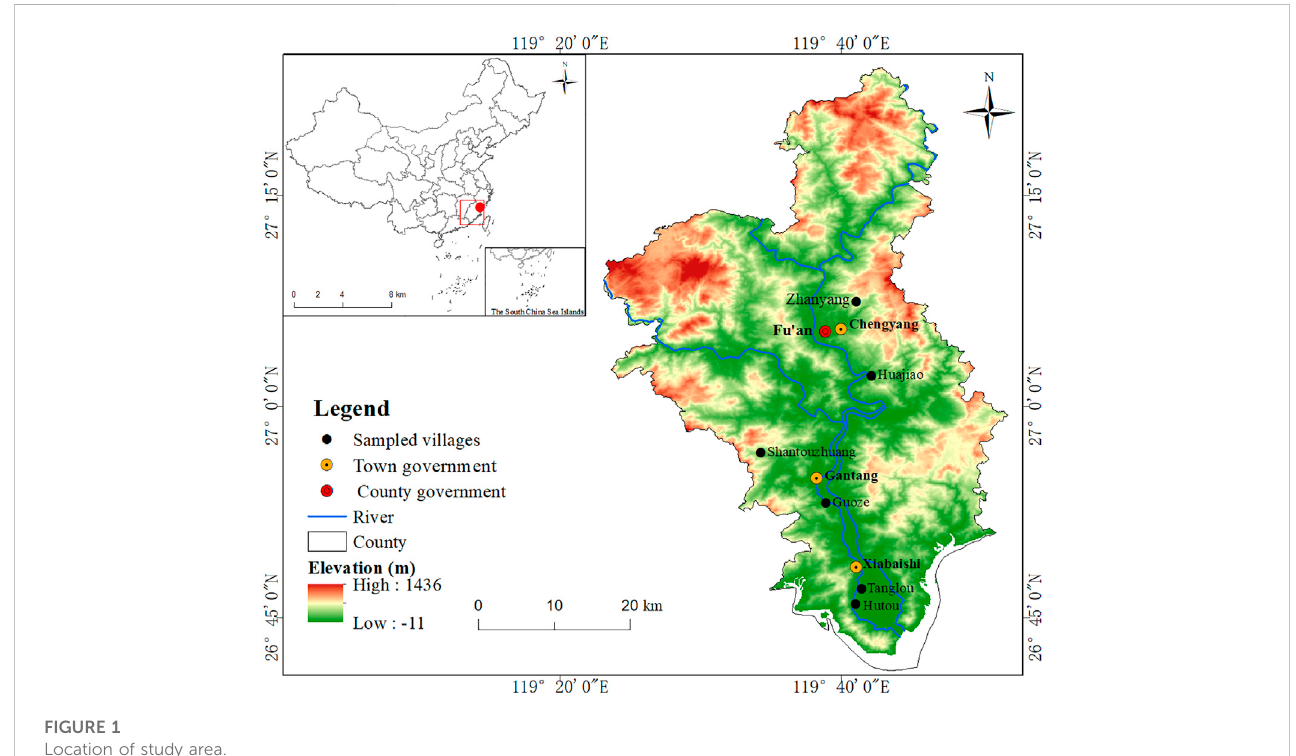
FIGURE 1 Location of study